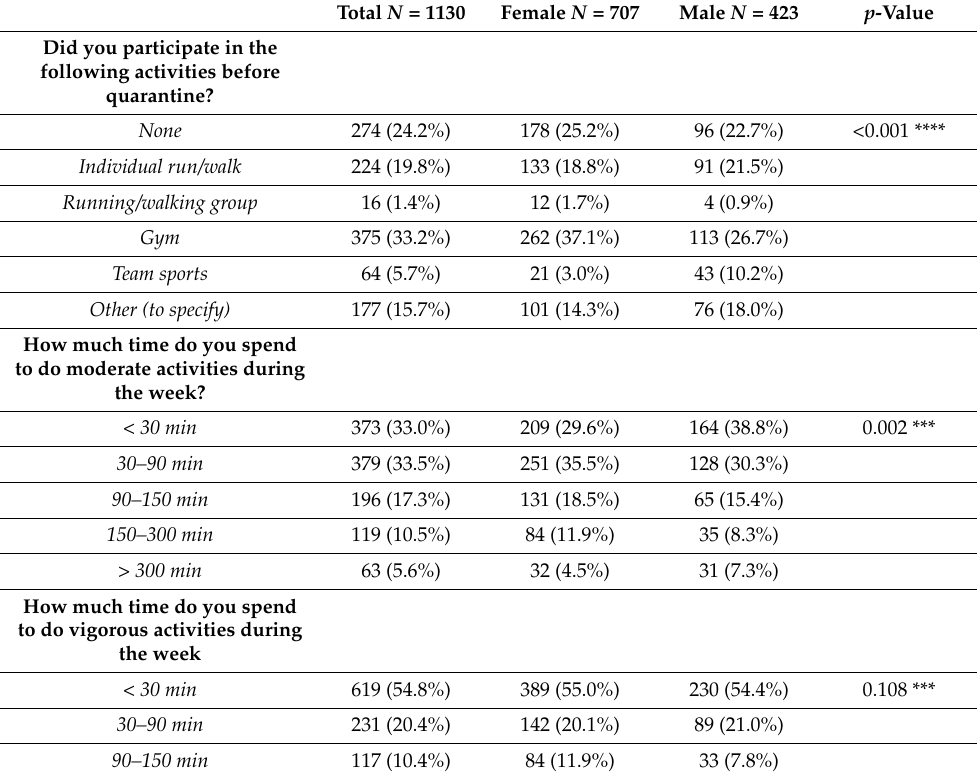
Table 5. Effects of the lockdown on physical activity habits of the university population and stratifi- cation by gender. Total N = 1130 Female N = 707 Male N = 423 p